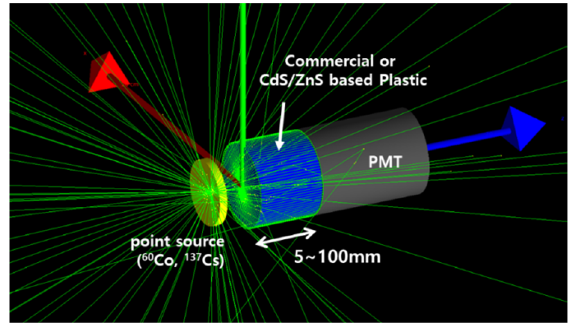
Figure 8. Geometry for application to GEANT4.